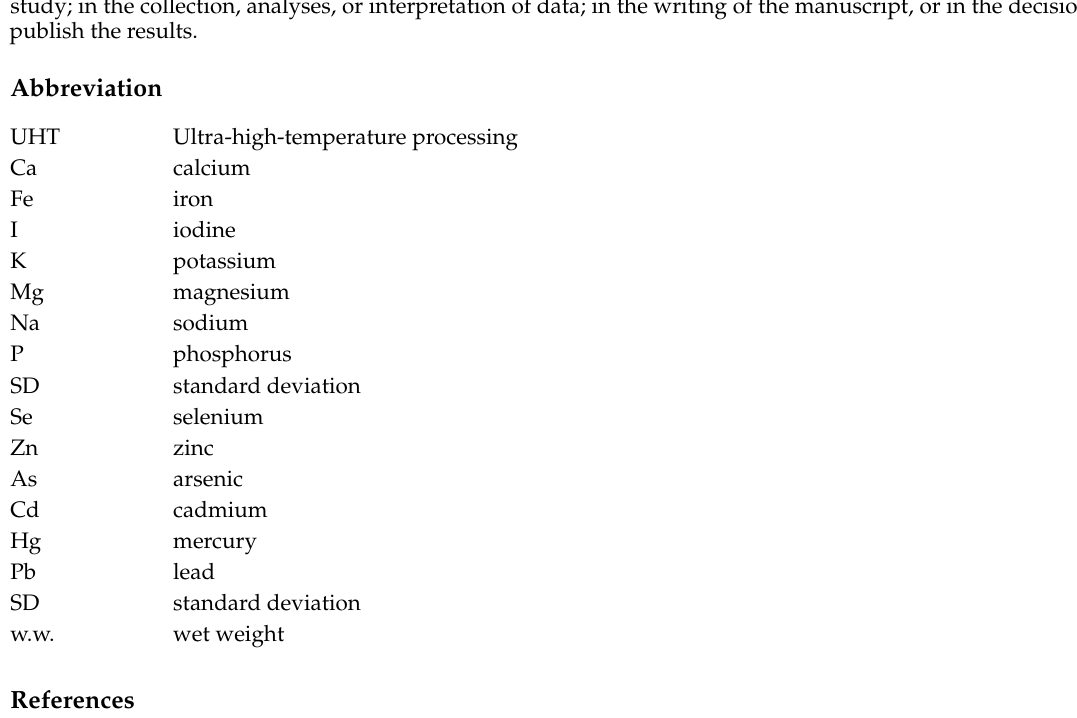
Table S1: analytical values of selected nutrients and contaminants in composite samples ( n = 5) of fillets of Lagocephalus laevigatus (smooth pu ff er) from Angola (mean standard ±